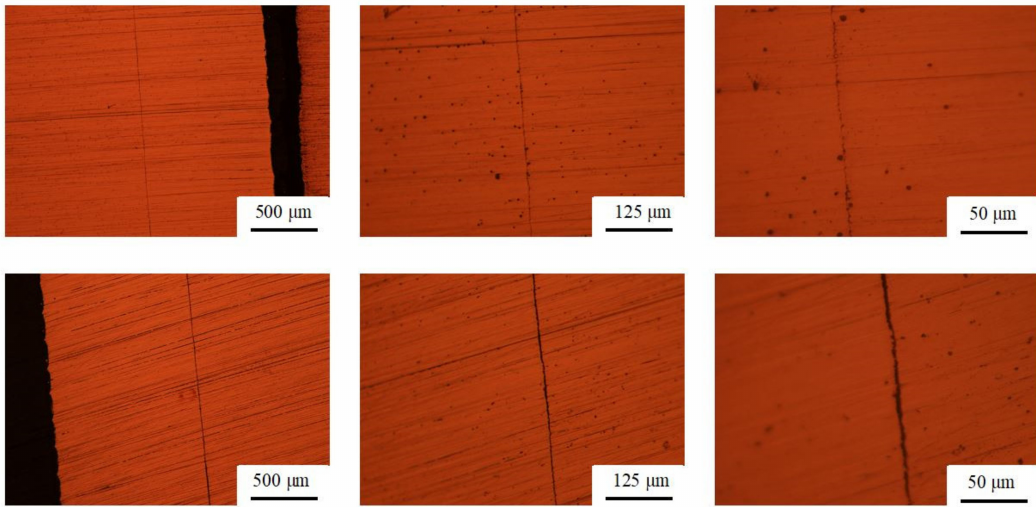
Figure 5. Metallographic images of longitudinal cross-sections (upper row: specimen #2.1; lower row: specimen #2.2).